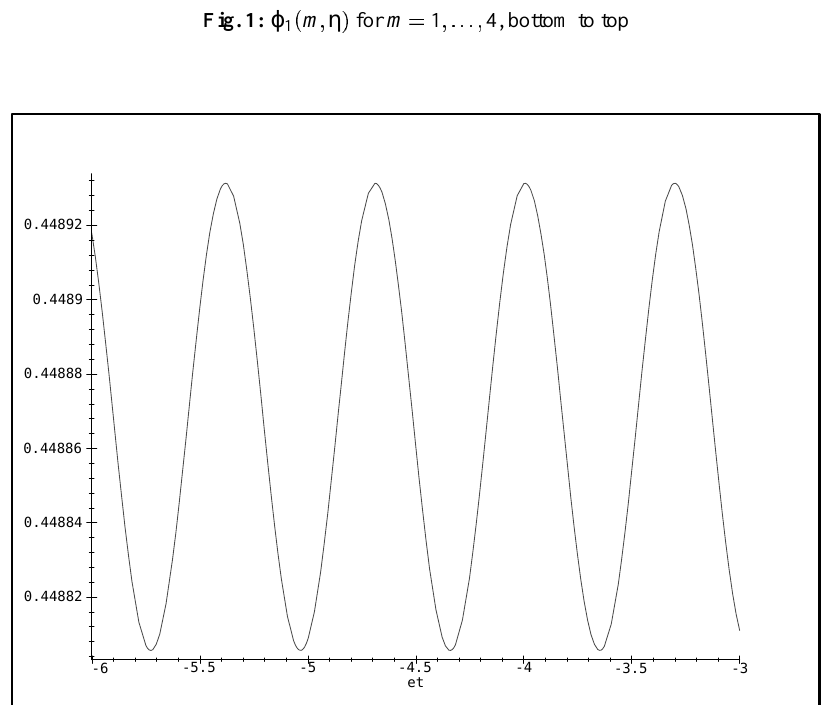
h for m (cid:5) (cid:1)